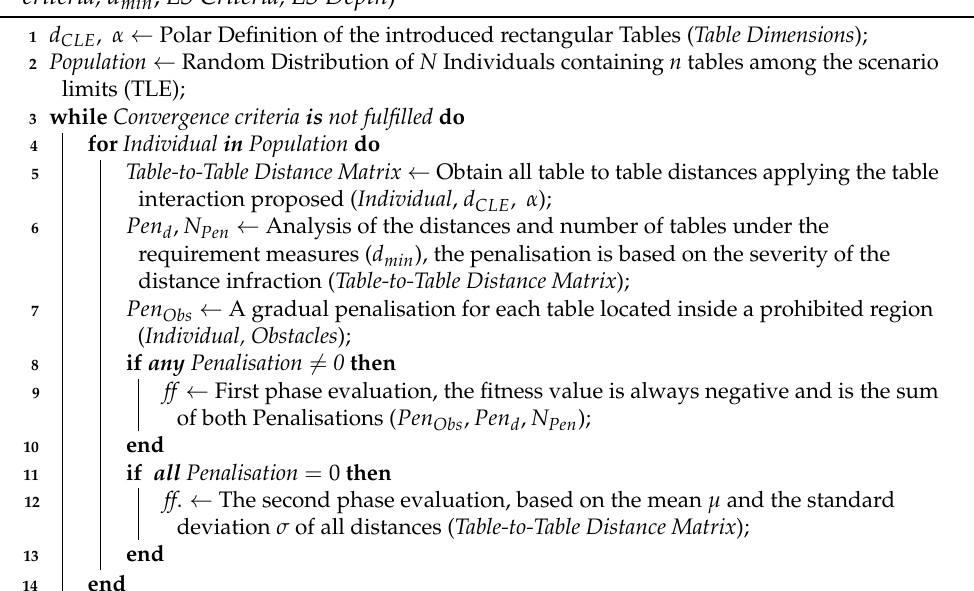
Algorithm 1: MA for the TLP ( Table Dimensions, N, n, TLE, Obstacles, Convergence criteria, d min , LS Criteria, LS Depth